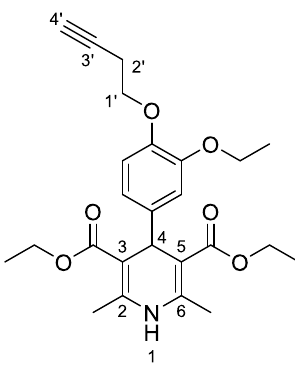
Figure 17. Chemical stucture of 3p .